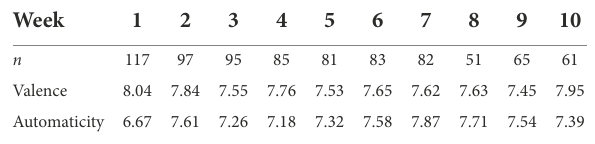
TABLE 3 Means of weekly measured variables.